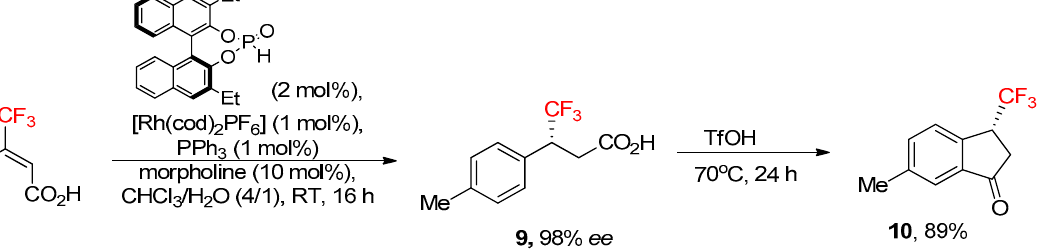
Scheme 6. Cyclization of CF 3 -acid 9 into CF 3 -indanone 10 in TfOH. Fruitful CF 3 precursors for the building of an indane core under electrophilic activation conditions are trifluoromethyl ketones. Thus, CF 3 - β -diketones bearing trifluoroalkyl or heterocyclic substituents 11a-d in reaction with benzene in neat TfOH give stereoselective 1- (Scheme 7). There is an electrophilic activation of carbonyl carbons in diketones 11a-d due